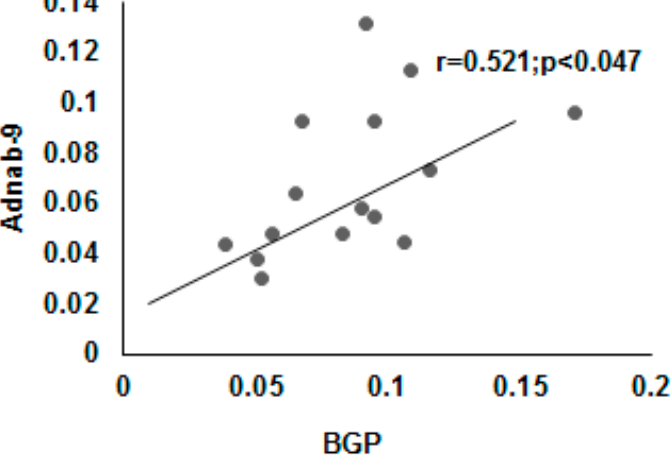
Figure 9. The correlation between BGP and Adnab-9 epitope expression in colonic tissues of CTT and CM. The scatter gram plot shows a statistically significant correlation between BGP antibody binding and Adnab-9 antibody binding by ELISA as previously published in [34].